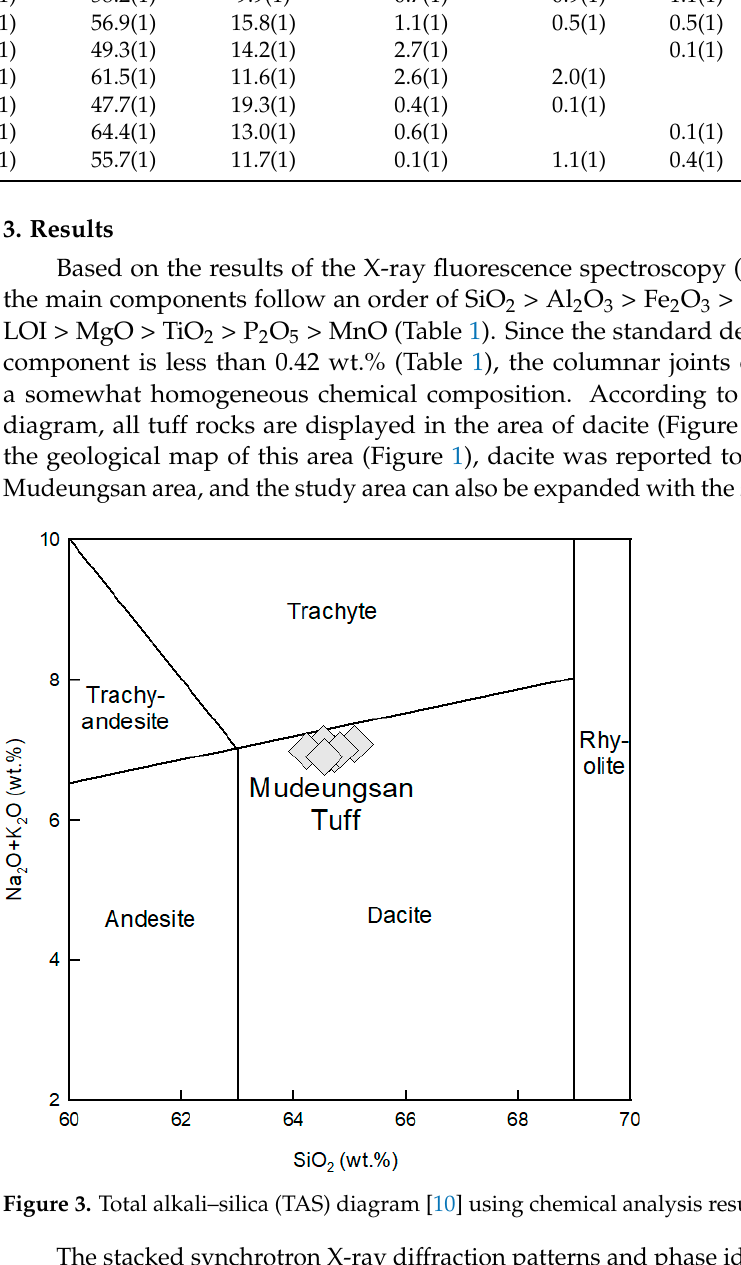
Table 2. Quantitative phase analysis results using Rietveld refinement (in%).